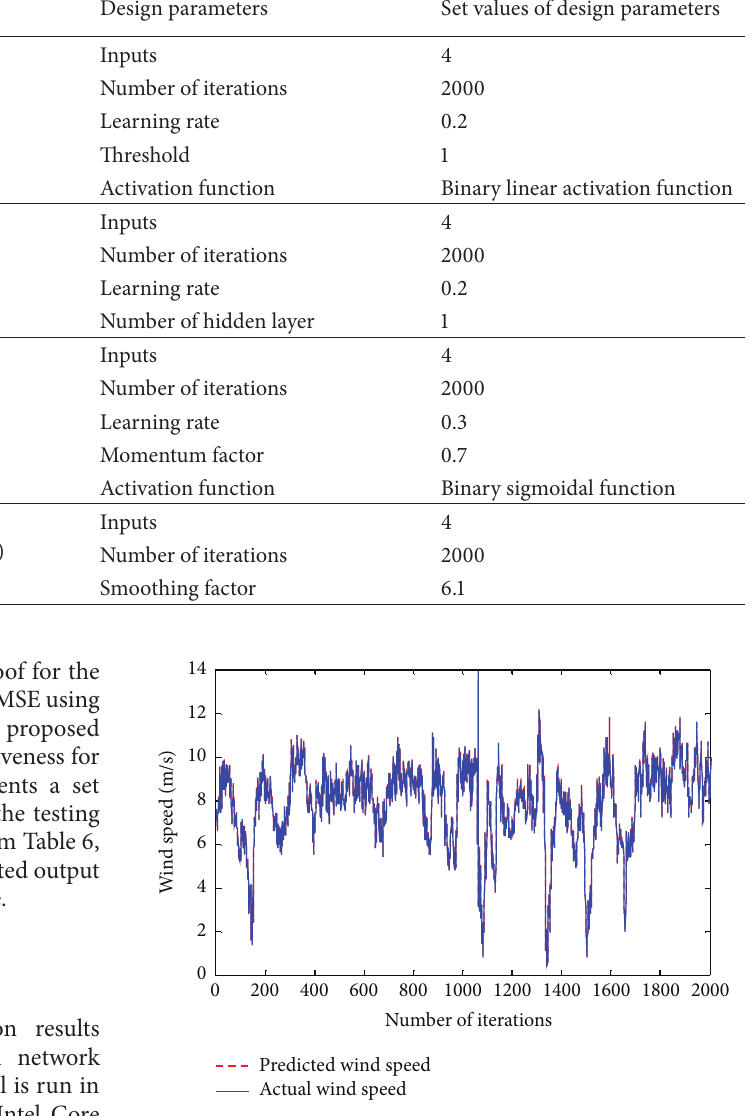
Table 4: Design parameters of the proposed ensemble NN model. Sl. number